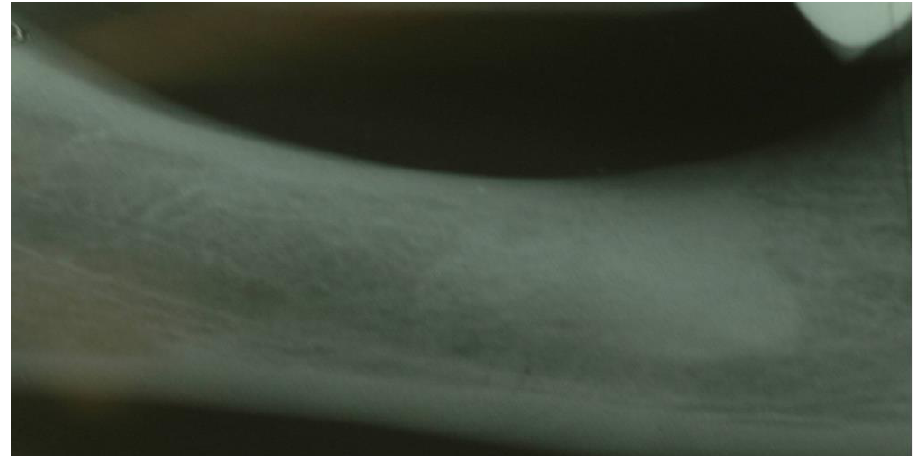
Figure 1. Preoperative intraoral radiograph of the edentulous area.